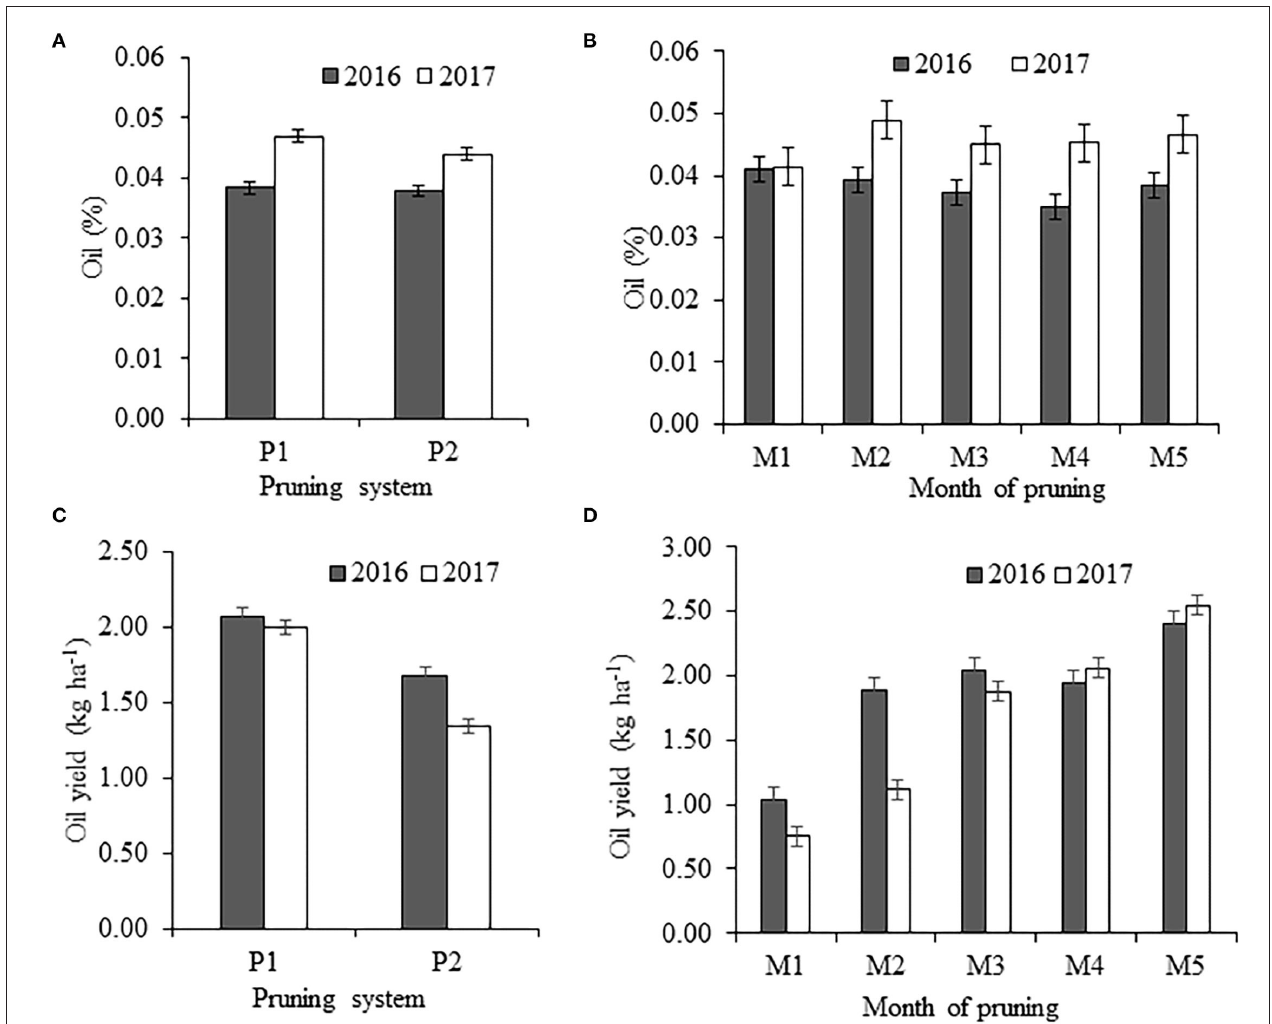
FIGURE 2 | Effect of pruning system and month of ground-level pruning on the oil content (%) in flower (A,B) and oil yield (kg ha − 1 ) (C,D) during the years 2015–2016 and 2016–2017, and the vertical bars indicate mean standard